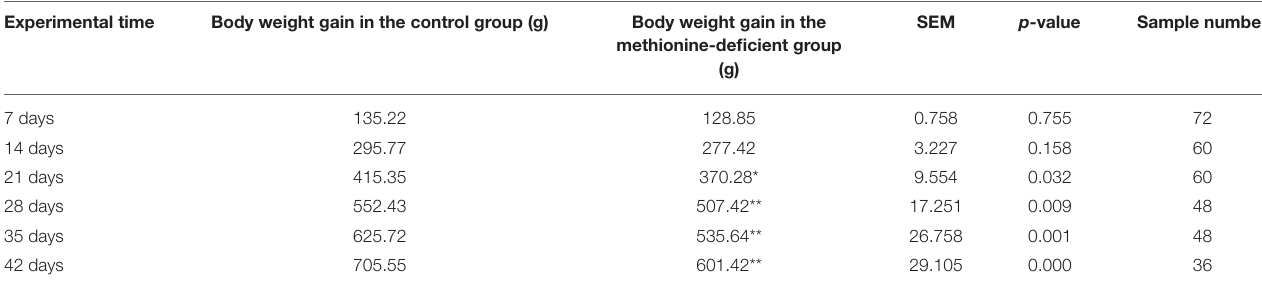
TABLE 2 | Body weight changes of broilers in the control and methionine deficiency